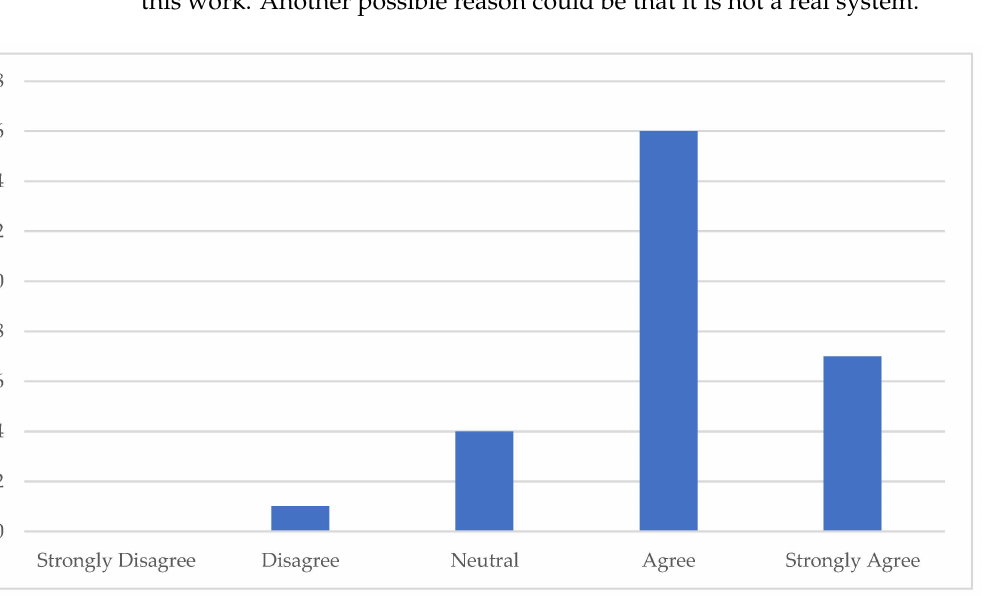
Figure 9. Level of conformance regarding the functionalities provided by the system